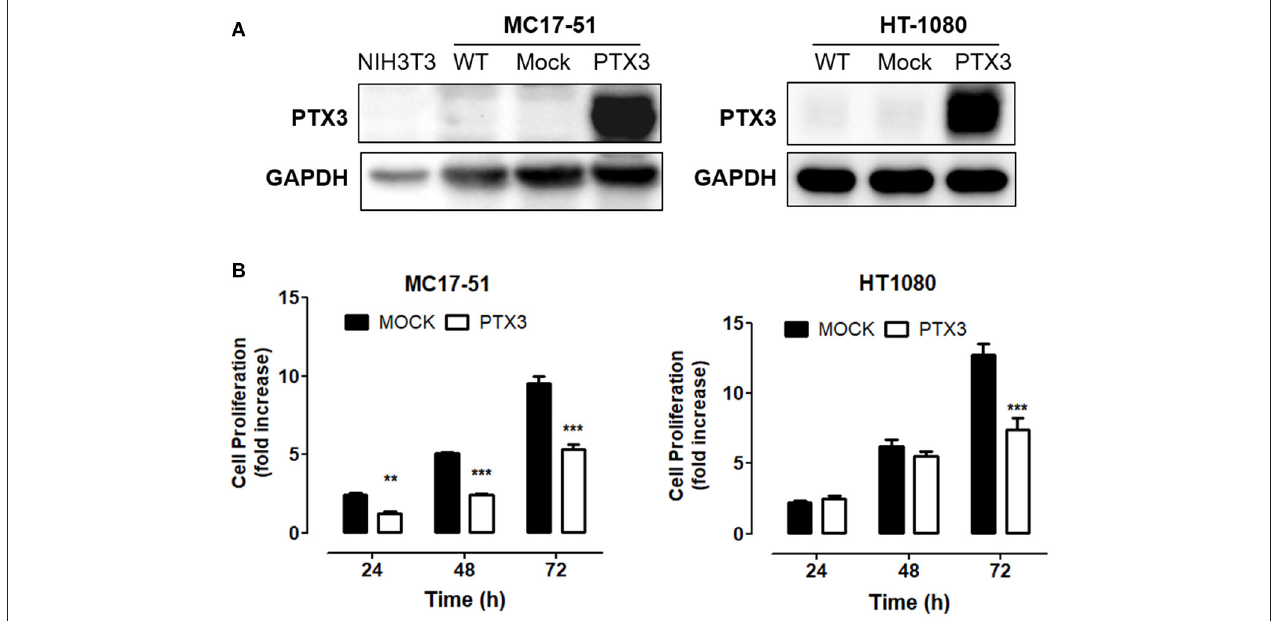
FIGURE 1 | PTX3 impairs fibrosarcoma proliferation in vitro . (A) Western blot analysis of PTX3 expression in wild type (WT), empty vector- transduced (Mock), and PTX3-overexpressing (PTX3) MC17-51 and HT-1080 cells. (B) Proliferation of control (mock) and PTX3-overexpressing (PTX3) MC17-51 and HT-1080 cells at 24, 48, and 72h. Cell proliferation is expressed as fold increase in respect to the number of seeded cells; data are the mean ± S.E.M of 3 independent determinations (** P < 0.01, *** P < 0.001, Student’s t -test).